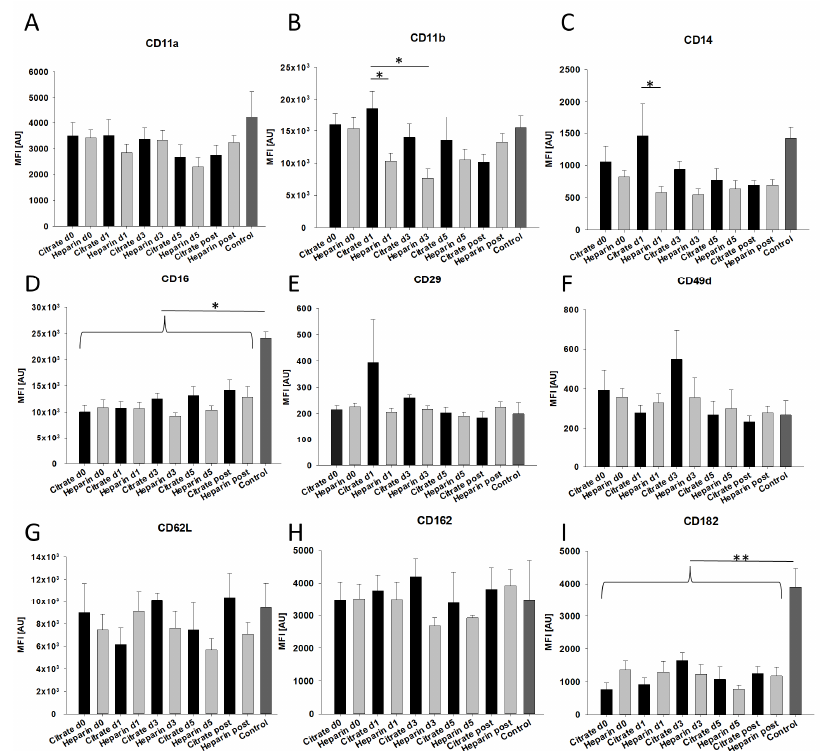
Figure 1. Neutrophil surface expression. Levels of important neutrophil surface molecules (CD11a ( A ), CD11b ( B ), CD14 ( C ), CD16 ( D ), CD29 ( E ), CD49d ( F ), CD62L ( G ), CD162 ( H ), CD182 ( I )) were measured by flow cytometry in density-gradient-isolated neutrophils from critically ill patients ex- periencing acute kidney injury before (d0), during (d1, d3, d5) and after (d1 post) either regional- citrate- or systemic-heparin-based continuous veno-venous hemofiltration and from healthy volun- teers (control). Mean fluorescence intensity (MFI) measurements of CD11b and CD14 differed be- tween citrate and heparin groups. CD16 and CD182 surface levels were all significantly reduced in comparison to healthy controls. (n ≥ 3 individual patients; * p < 0.05; ** p < 0.01; mean ± SEM).